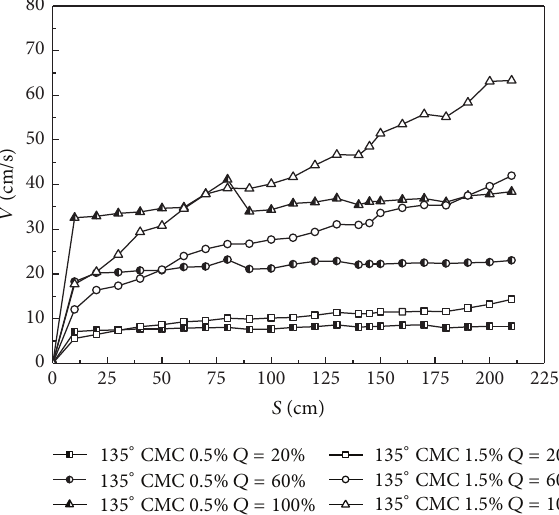
Figure 11: The CMC velocity-position diagram of various flow in 135 ∘ curved